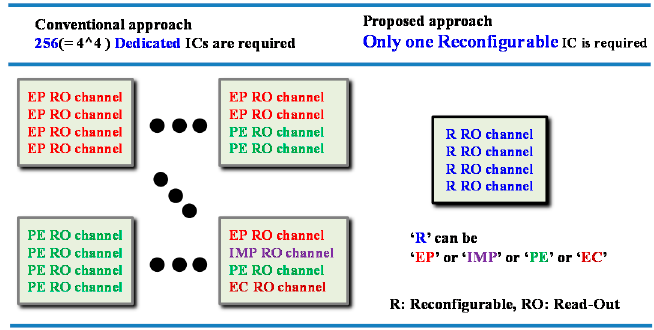
Figure 2. Required number of integrated circuits (ICs) to adapt various applications for four interface channels in the conventional and proposed approaches.